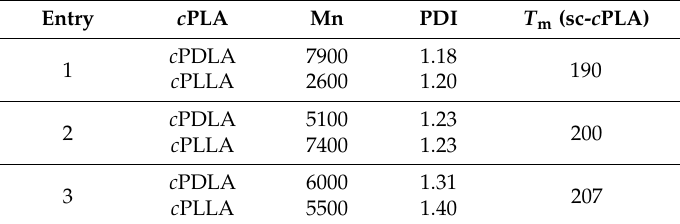
Table 3. Stereocomplex of PLA with different ring sizes.